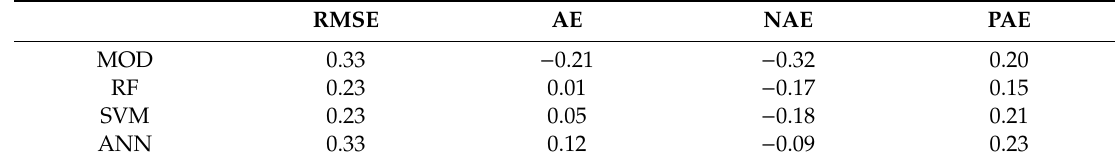
Figure 5. Accuracy assessment including for FSC retrieved from the MOD10A1 (MOD) and random forest (RF), support vector machine (SVM), and back-propagation artificial neural network (ANN) using Landsat OLI. The root mean square error (RMSE), average error (AE), positive average error (PAE) and negative average error (NAE) were adopted to evaluate the FSC models. Table 3. Error evaluation of MOD10A1 (MOD), random forest (RF), support vector machine (SVM) and back-propagation artificial neural network (ANN).